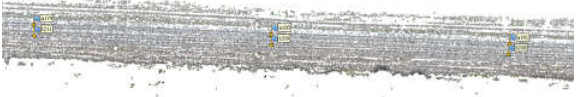
Figure 3. A fragment of the photogrammetric model with control points placed by pairs every 200 m